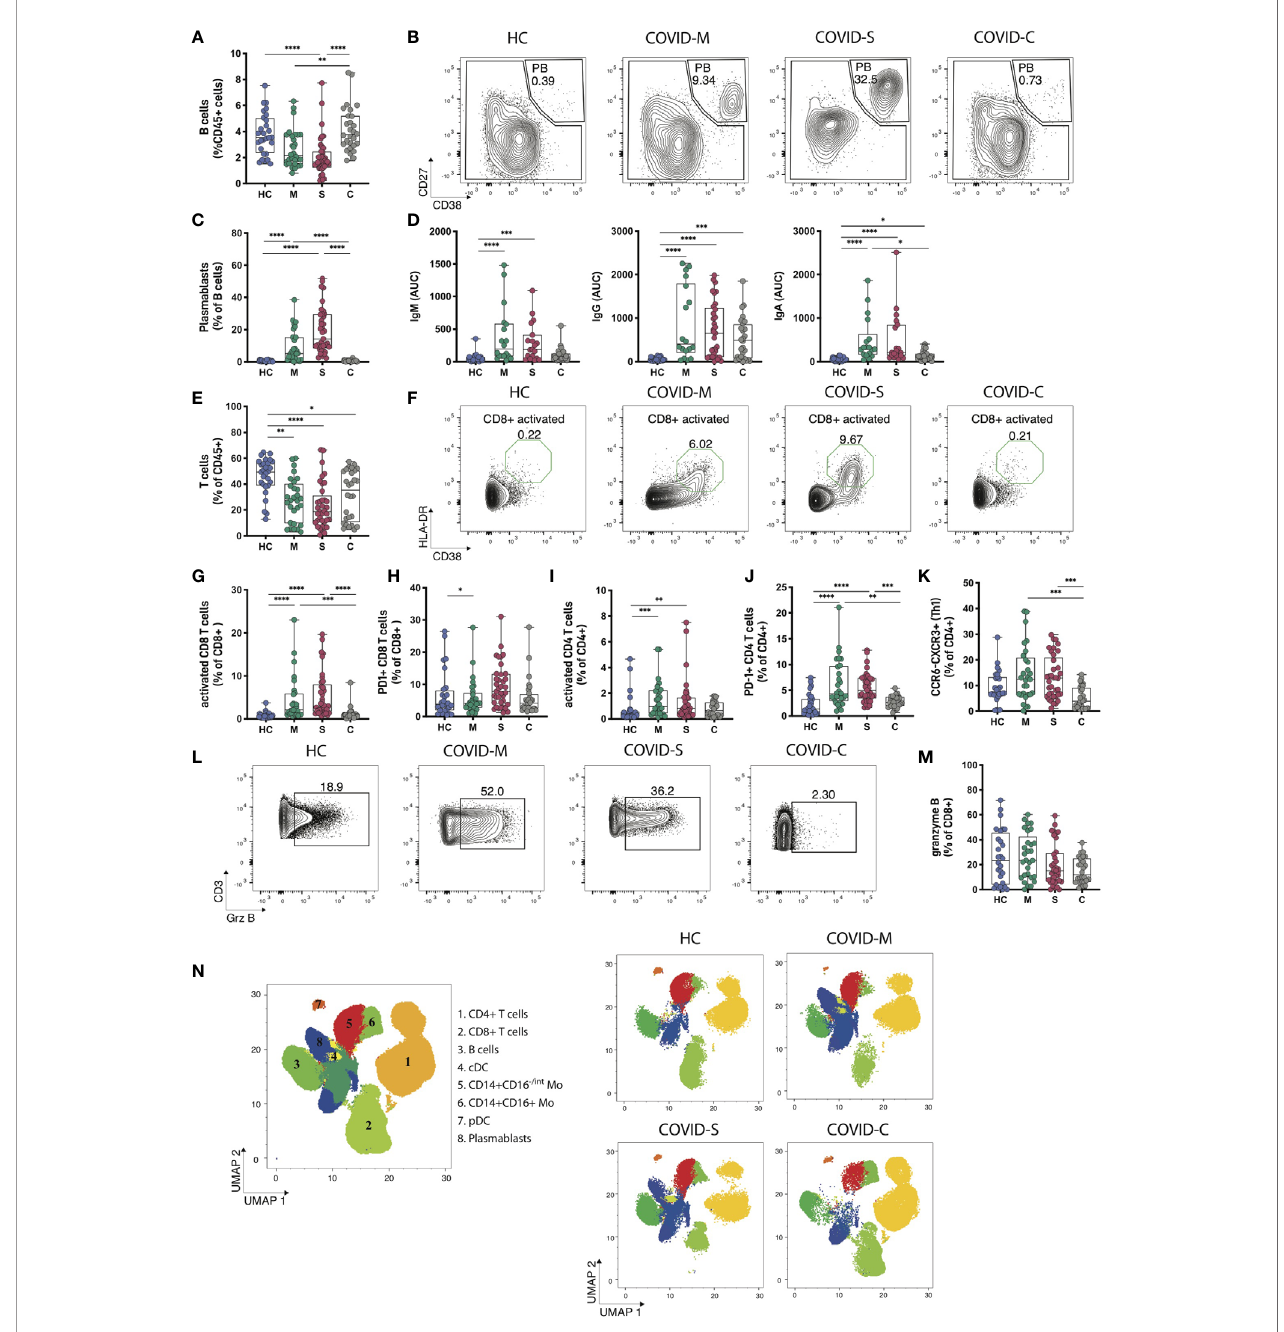
FIGURE 2 | Immune pro fi ling of adaptive immune responses in COVID-19 patients. B and T cell populations were analyzed through multiparametric fl ow cytometry in peripheral blood samples of COVID-19 patients with moderate and severe disease, convalescent COVID-19 patients and healthy controls. (A) Frequency of B cells within CD45 + leukocytes. (B, C) Representative plots and percentages of plasmablasts populations. (D) SARS-CoV-2 Spike protein-speci fi c immunoglobulin levels measured in plasma from COVID-19 patients and healthy controls. (E) Frequency of T cells within CD45 + leukocytes in peripheral blood. (F, G) Representative plots and frequency of activated (F, G) and exhausted (H) populations within the CD8 T cell compartment. (I – K) Frequency of activated (I) exhausted (J) and Th1 equivalents (CCR6 - CXCR5 + ) populations within the CD4 T cell compartment. (L, M) Representative plots and frequency rates of granzyme B+ CD8 T cells. (N) UMAP of fl ow cytometry data of main leukocyte populations present in PBMC samples with representative images for moderate, severe, and convalescent COVID-19 patients in addition to healthy controls. Key numbers for cell subsets are indicated in the concatenated image. HC = Healthy controls, n = 28; M = COVID-Moderate, n = 29; S = COVID-Severe, n = 37; C = COVID-Convalescent, n = 28. Differences between groups were calculated using Kruskal-Wallis test and Dunn ’ s multiple comparison post-test (*p = 0,05; **p = 0,01; ***p = 0,001, ****p =